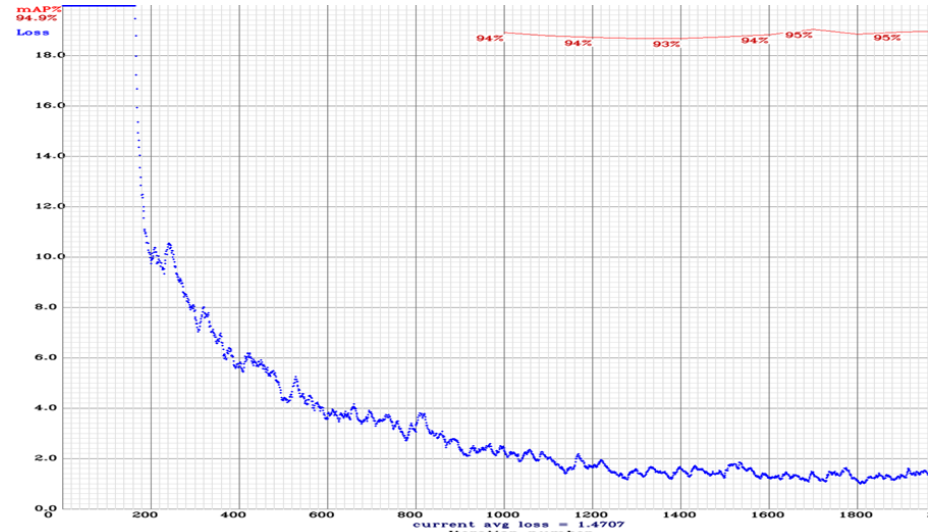
Figure 8. Model training loss graph.